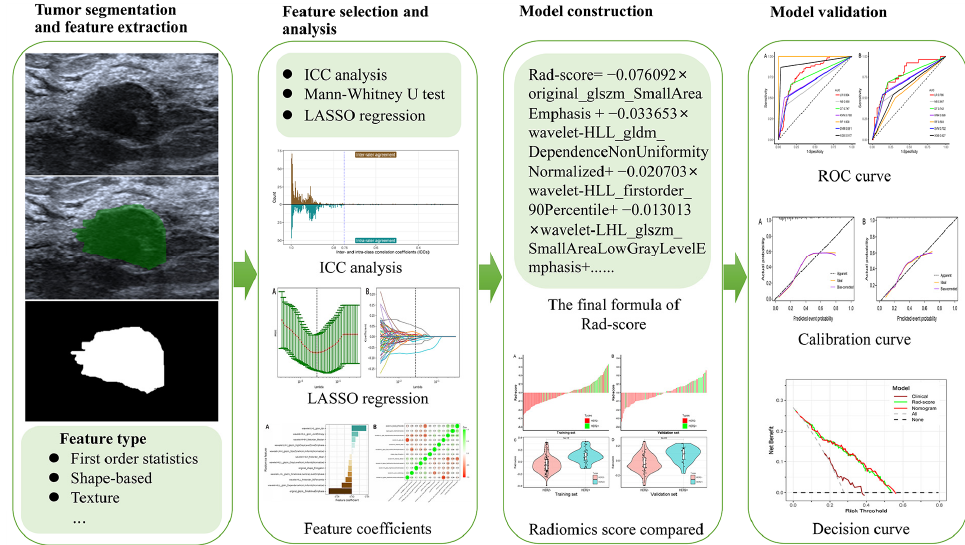
Figure 2. Schematic representation of the radiomics analysis steps.